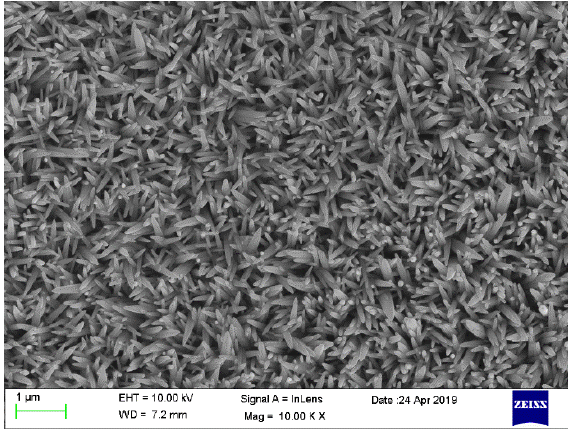
Figure 1. Scanning electron microscopy (SEM) image of ZnO nanorods.